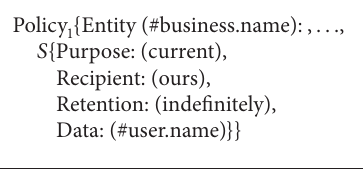
Algorithm 3: P3P privacy policies of three single services (Policy